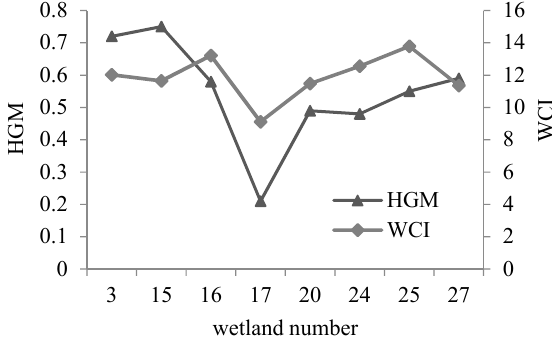
Figure 9. The values of WCI compared with the HGM in the wetland in Xianlin sub-city.